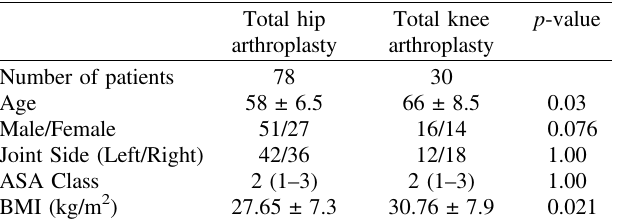
Table 2. Demographic results of HIV-positive total joint arthroplasty population.